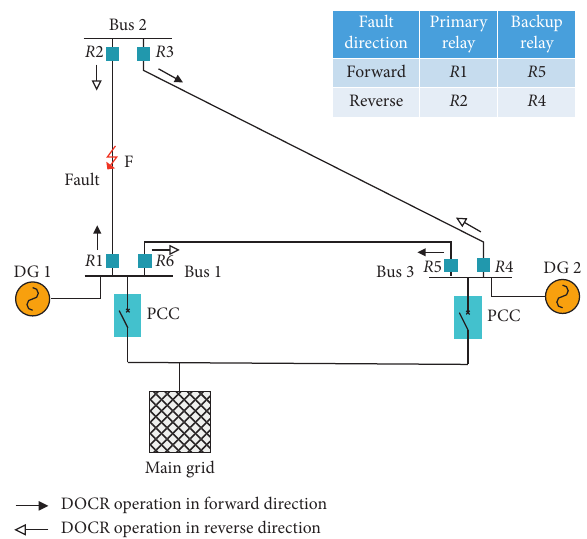
Figure 2: Operation of DOCRs with the conventional protection